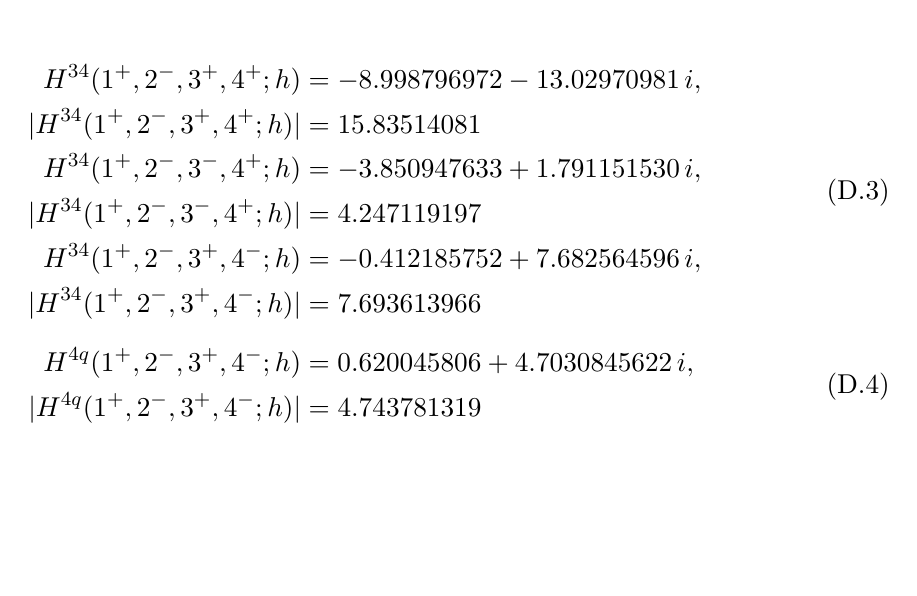
Table 7 . Numerical values of coe(cid:14)cients and rational terms for + { + { and + + { { helicities of ggggh at kinematic point,